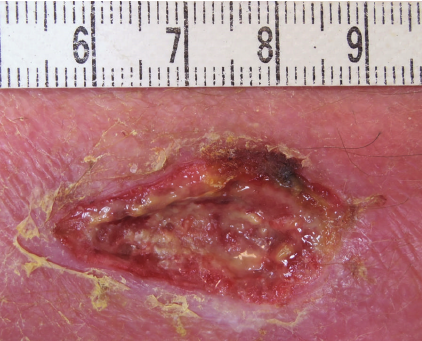
Figure 2: Wound, following seven days of ofloxacin (Tarivid) and following daily debridement, eight days after opening by removing the surgical threat. (Bar at the top is in